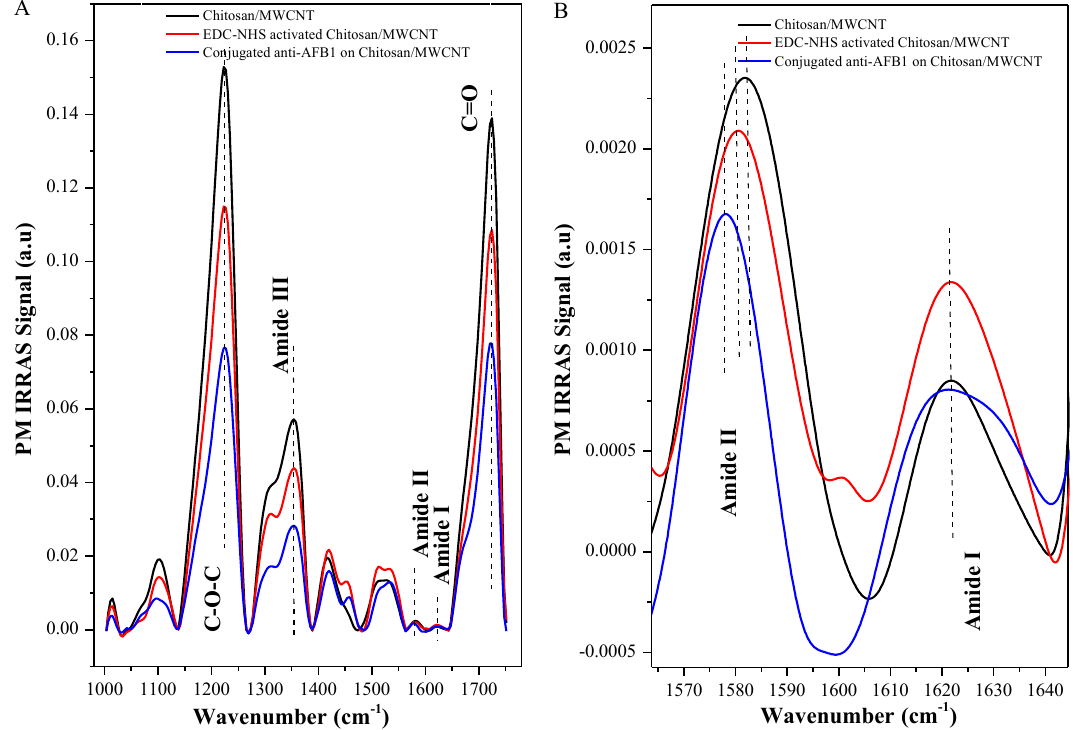
Figure 4. ( A ) Polarization-modulated infrared reflection absorption spectroscopy (PM-IRRAS) spectra for the chitosan/MWCNT at different steps of anti-AFB1 conjugation and ( B )